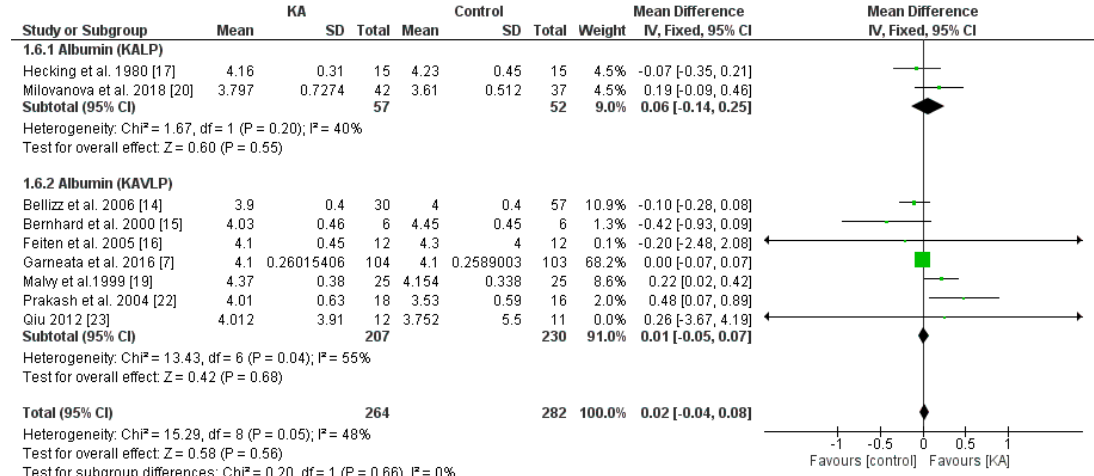
Figure 7. Forest plot of effects of KA on albumin levels in CKD patients sub-grouped by eGFR. The random-effects model was utilized.